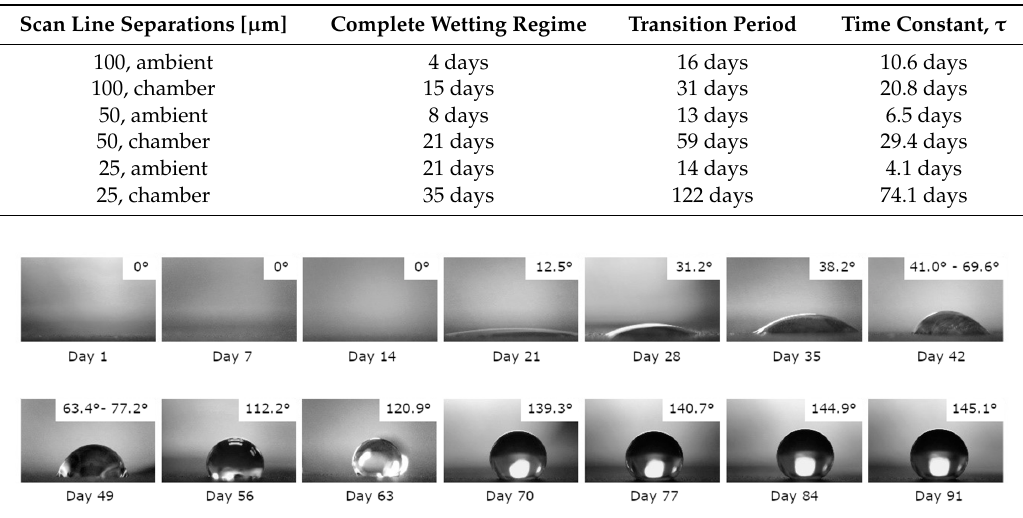
Figure 2. Short- and long-term development of static water contact angles with characteristic exponential growth fits and corresponding time constants of uncoated laser-textured steel surfaces with different scanning line separations ( ∆ x = ∆ y = 100, 50, 25 μ m), stored in ambient conditions and in a chamber with reduced air pressure and humidity. Table 2. Comparison of wettability development with corresponding time constants on samples stored in ambient conditions and in a chamber with reduced air pressure and humidity: time evaluation of complete wetting regime and transition period.